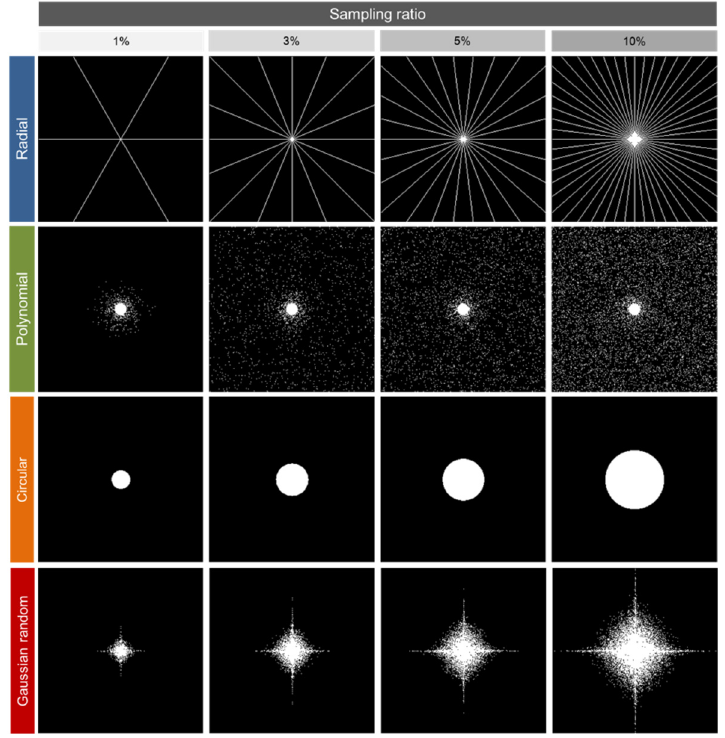
Figure 3. Sampling masks used in the simulations and the experiments.